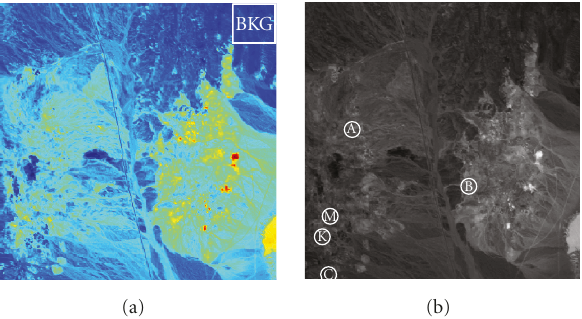
Figure 1: (a) Cuprite AVIRIS image scene, (b) spatial positions of five pure pixels corresponding to minerals: alunite (A), budding- tonite (B), calcite (C), kaolinite (K), and muscovite (M).